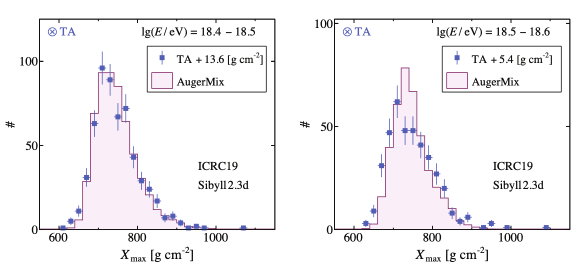
Figure 5. Example of a comparison between TA and Auger ⊗ TA with a good AD p -values (left) with 18 . 4 < log and one with a bad p -value (right) with 18 . 5 < log 18 . 6.